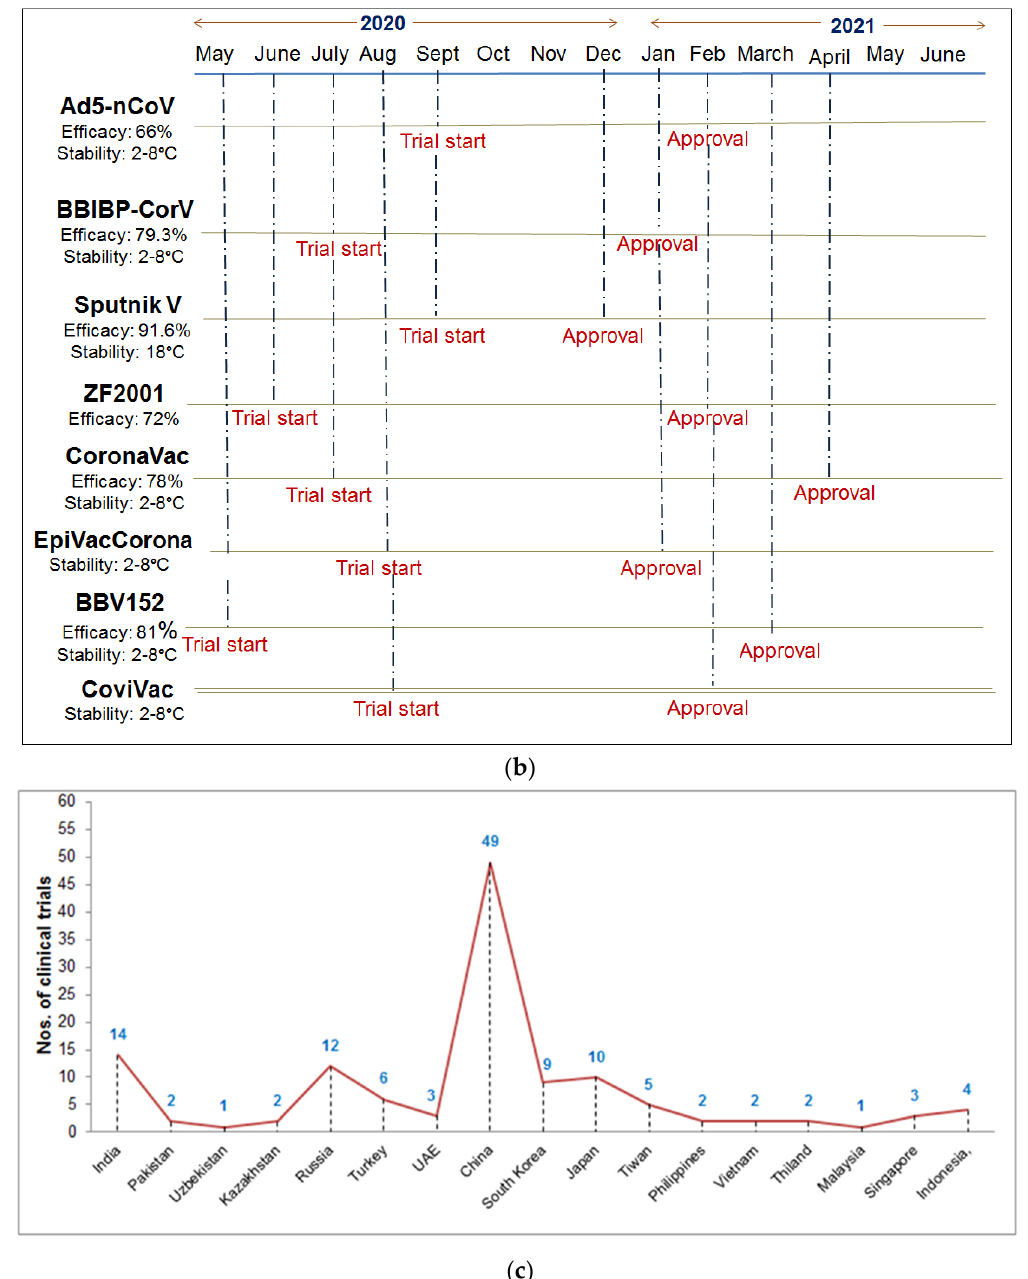
Figure 3. The entire clinical trial landscape of the different COVID-19 vaccines throughout the globe. (a) Evaluation report of the total registration of the clinical trials (by a week) mapped from COVID-19 NMA database (https://covid-nma.com, accessed on 25 May 2021) [42]. (b) The schematic diagram represents some COVID-19 Asian-origin vaccines. Diagram represent the possible time for the trail to start, date of approval, storage temperature, and efficacy. (c) Numbers of clinical trials of Asian-originated COVID-19 vaccines (Vaccine Tracker, Statista, COVID-NMA, ClinicalTrials.gov).